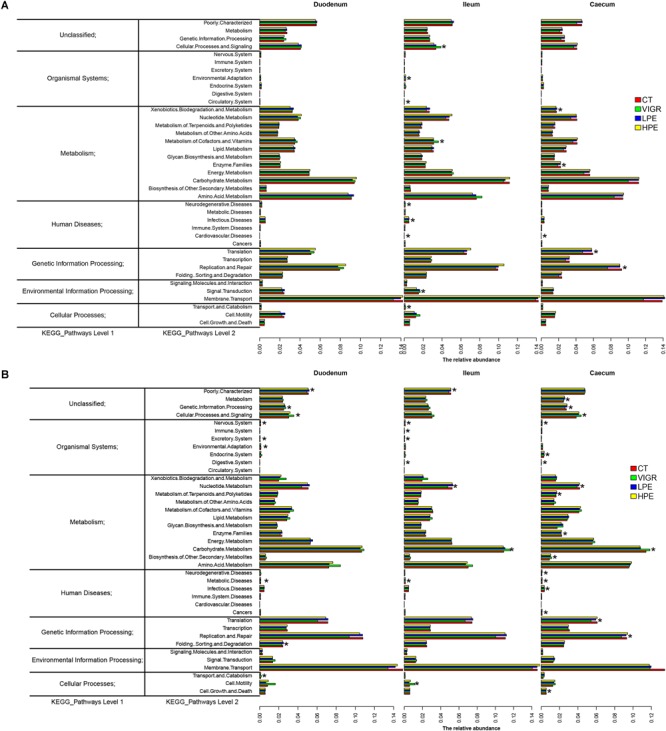
Genes overrepresented in the level 2 KEGG pathways in the duodenal, ileal, and cecal microbiotas of broilers on (A) day 14 and (B) day 28. CT, basal diet (control); VIRG, basal diet supplemented with 30 mg/kg virginiamycin; LPE, basal diet supplemented with 200 mg/kg plant extracts; HPE, basal diet supplemented with 400 mg/kg plant extracts.